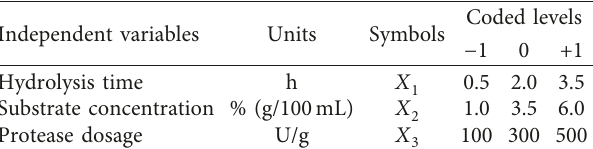
Table 1: Independent variables and their coded and actual values used for